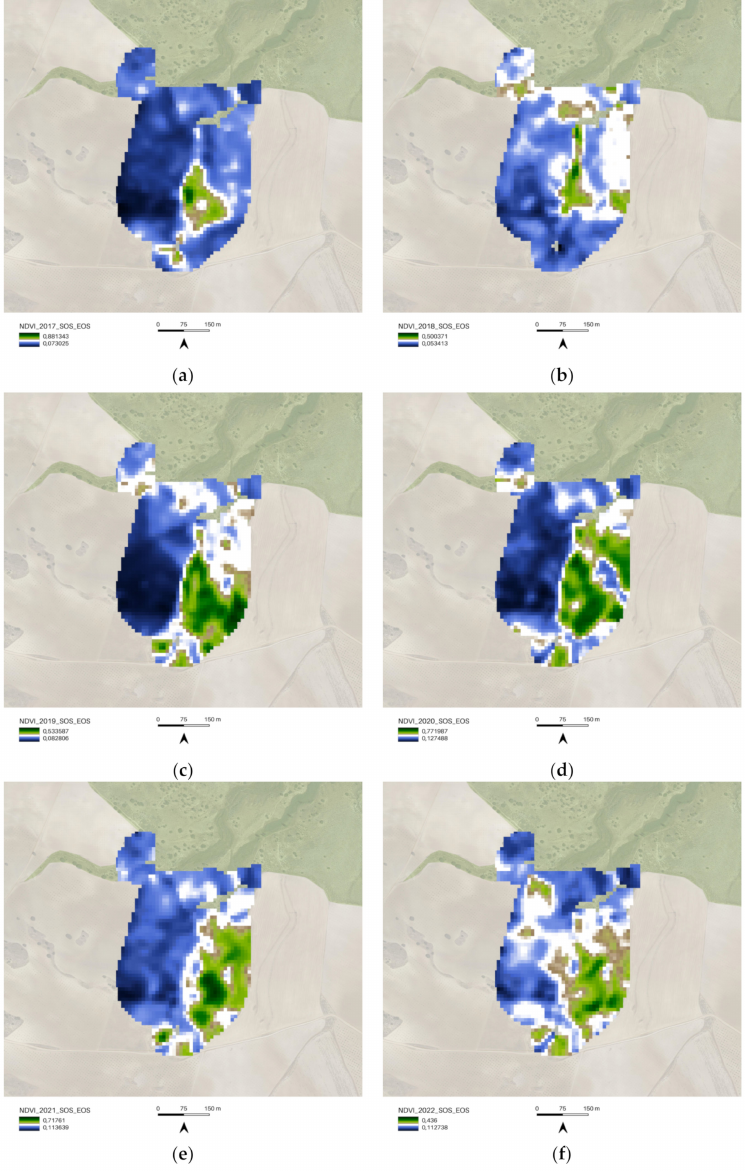
Figure 10. AOI.shp COPERNICUS/S2_SR NDVI vegetation trends SOS-EOS; ( a ) 2017 COPERNI- CUS/S2_SR filter dates SOS 2017-03-01, EOS 2017-05-31; ( b ) 2018 COPERNICUS/S2_SR filter dates SOS 2018-03-01, EOS 2018-05-31; ( c ) 2019 COPERNICUS/S2_SR filter dates SOS 2019-03-01, EOS 2019-05-31; ( d ) 2020 COPERNICUS/S2_SR filter dates SOS 2020-03-01, EOS 2020-05-31; ( e ) 2021 COPERNICUS/S2_SR filter dates SOS 2021-03-01, EOS 2021-05-31; ( f ) 2022 COPERNICUS/S2_SR filter dates SOS 2022-03-01, EOS